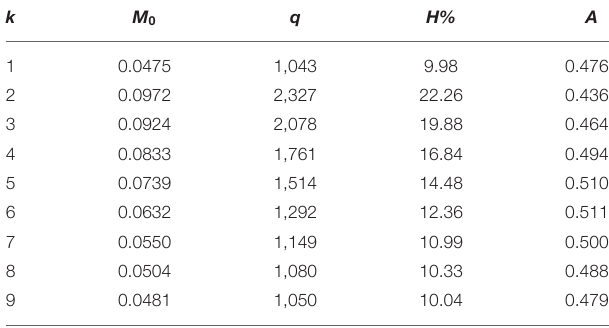
TABLE 4 | MHPI, q , H , and A in different cutoff ks